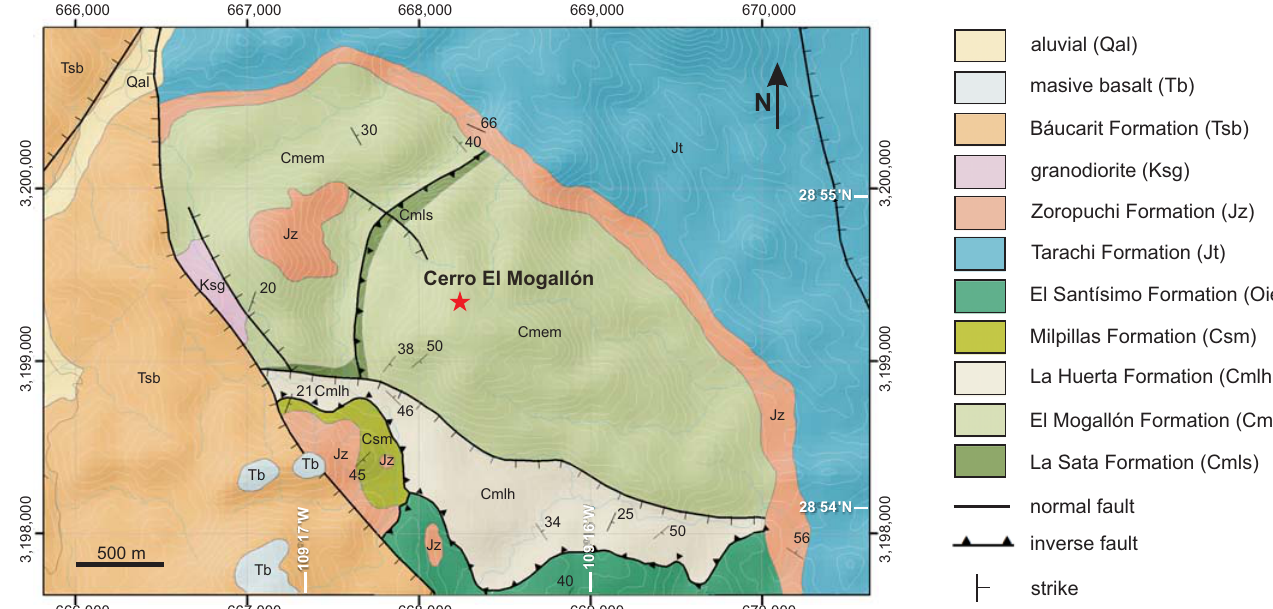
Fig. 2. Geological map showing position of the Cerro El Mogallón, and the Cambrian formations exposed in the Arivechi area, Sonora,